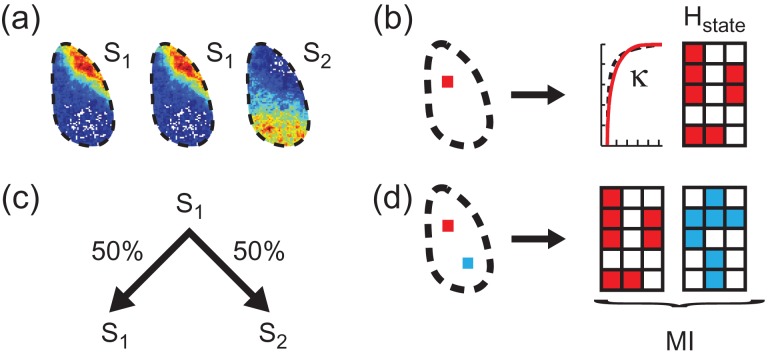
State analysis, κ, entropy and mutual information. (a) Three voltage images are assigned state labels S1 and S2 according to a k-means clustering algorithm. (b) Toy model showing a sequence of state indices for an image that consists of 3 pixels evolving over 5 time points. Activity within a single region (red square within the cortex), from which both κ and entropy (Hstate) are calculated. (c) Setting up a first-order Markov model for the three-image example in (a), state S1 has a 50/50 chance of transitioning to either state S1 or S2. (d) Toy model showing state sequences for a pair of images that each consist of 3 pixels evolving over 5 time points. Activity within two regions (red and blue squares within the cortex) from which their mutual information (MI) is calculated.